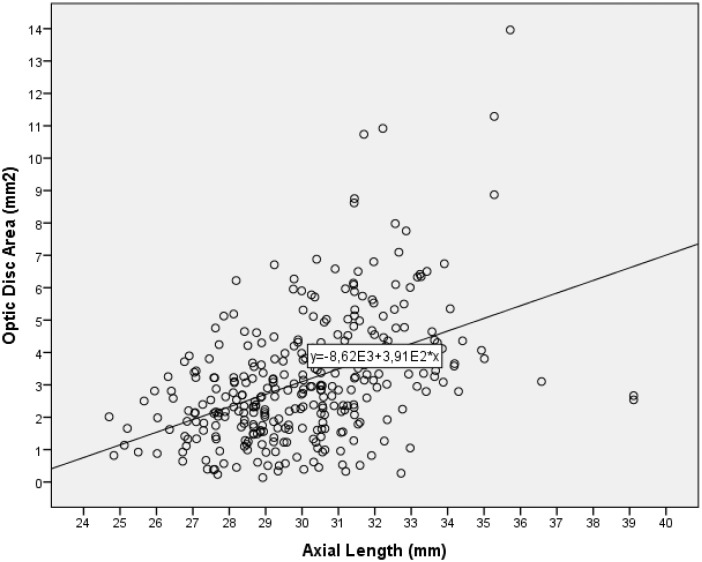
Correlation between axial length and optic disc size.In univariate analysis, optic disc area was significantly associated with axial length (P<0.001).